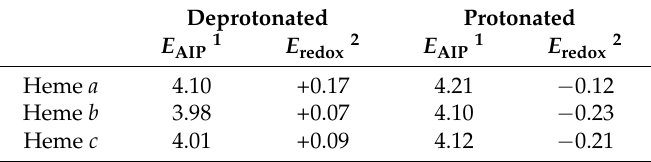
Table 4. The adiabatic ionization potential and estimated redox potential for each compound. Deprotonated